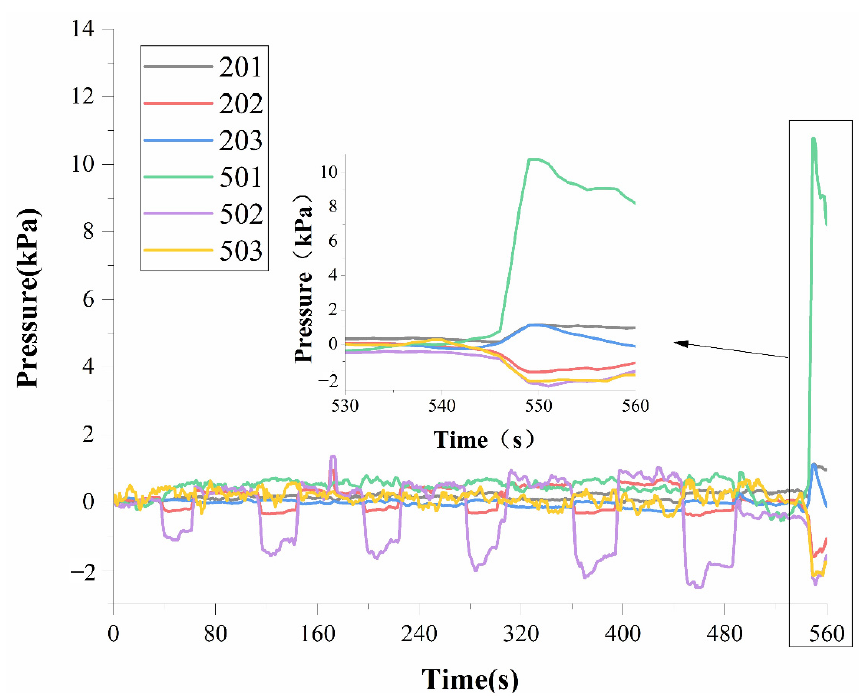
Figure 7. Pressure curves corresponding to each measurement point in a 20 mm-diameter circular crack.